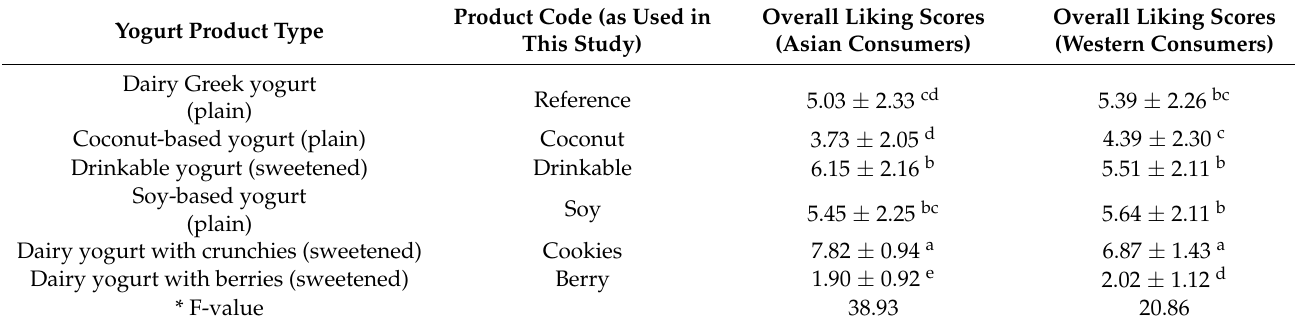
Table 1. Comparison of overall liking scores of the different yogurt products by Asian and Western consumers. Yogurt Product